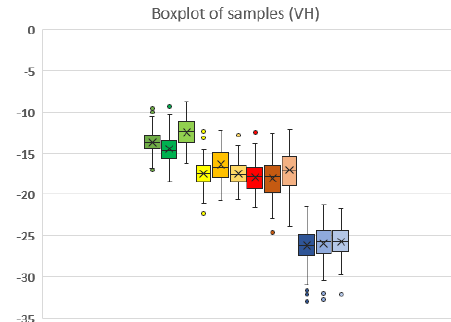
Figure 5. Box-plot of samples in VH polarization (dB). Green samples are dense forest samples, yellow-orange are sparse forest samples, red-brown are ground samples, and blue are water samples.